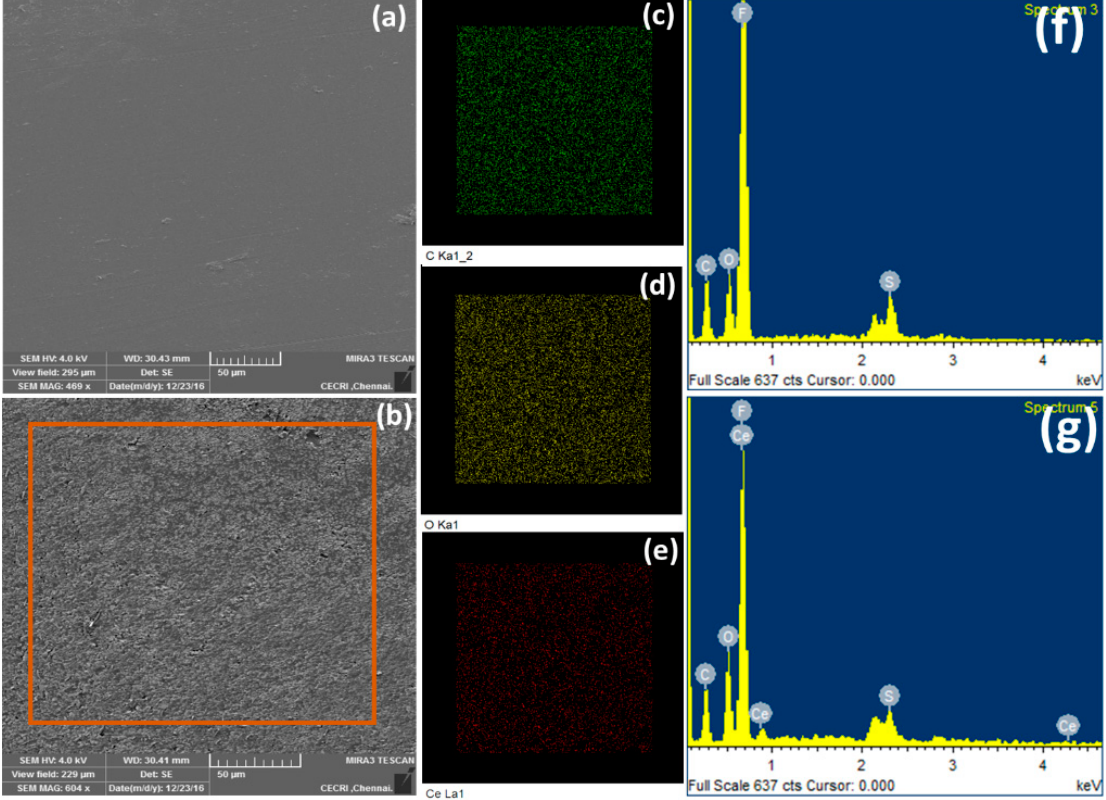
Figure 2. FE-SEM images of pristine Nafion ( a ) and Nafion-CeO 2 (1 wt. %) composite membrane ( b ); Corresponding quantitative EDX elemental mappings for carbon ( c ), oxygen ( d ), ceria ( e ) for Nafion-CeO 2 (1 wt. %) composite membrane (quantitative EDX elemental mapping performed on a particular area is marked in Figure 2b); EDX spectra of pristine Nafion ( f ) and Nafion-CeO 2 (1 wt. %) composite membrane ( g ).